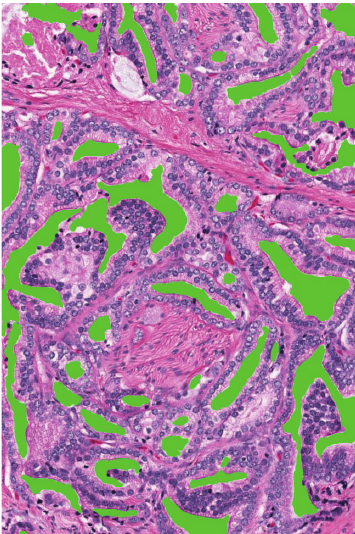
Figure 1: Image capture of undulating lumens grade 3 pattern, 1500 × 1000 pixels, after pseudolumen annotation. Lumens are very irregular; there is perineural invasion. Patient had PSA failure (100x).